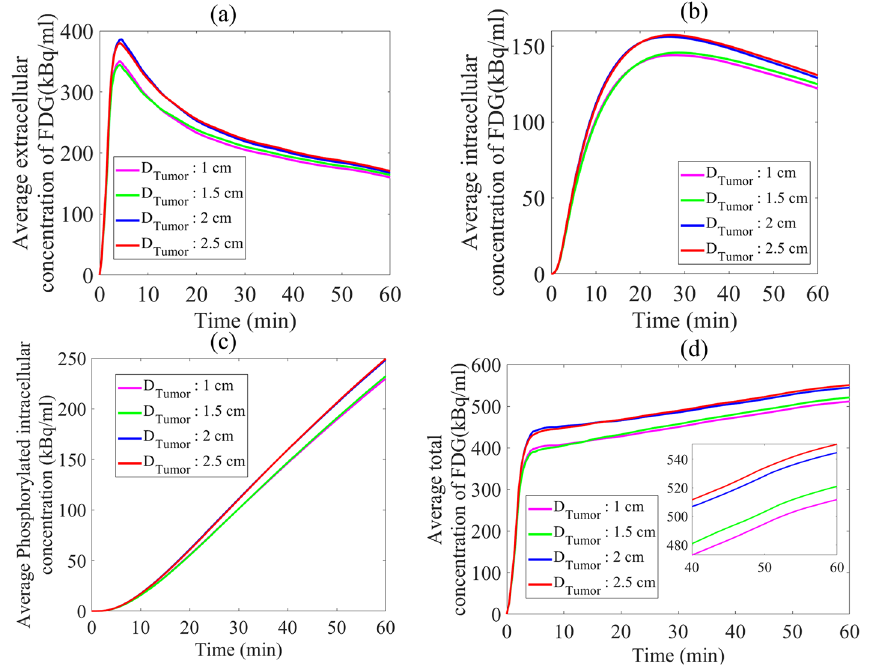
Figure 7. TACs of different concentrations of FDG. ( a ) Extracellular FDG, ( b ) intracellular FDG, ( c ) phosphorylated intracellular FDG, and ( d ) total FDG concentration within the tumor